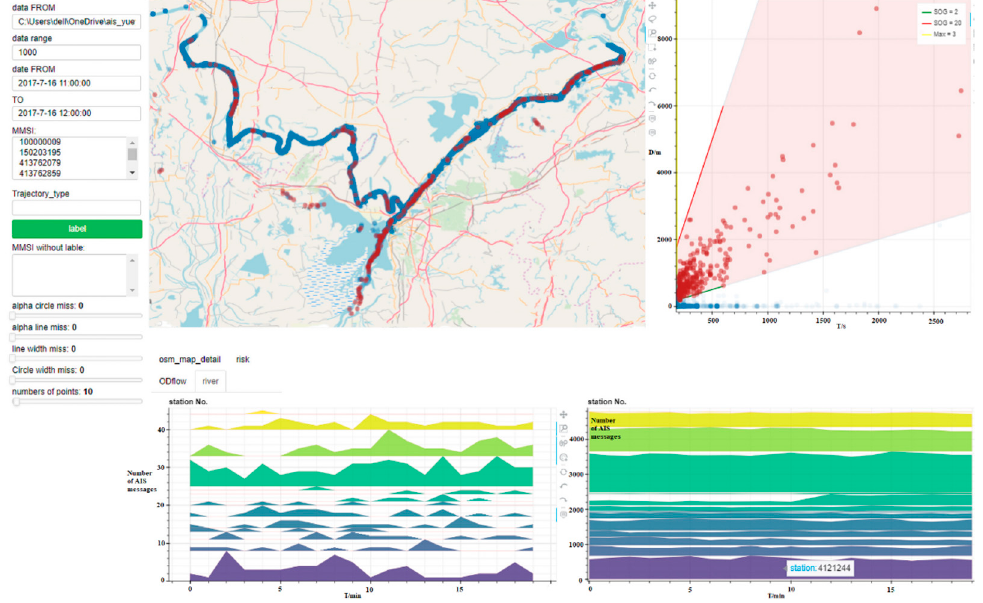
Figure 14. Visualization of missing data.